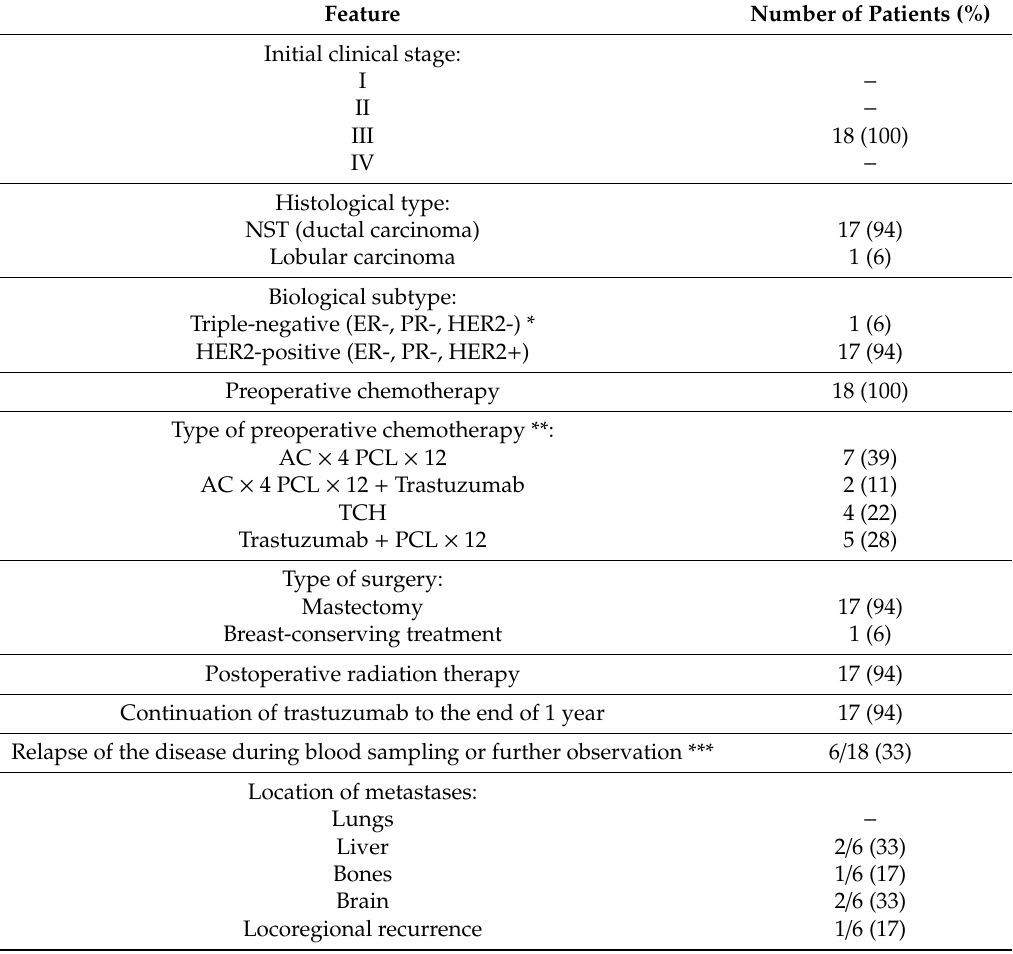
Table 1. Characteristics of patients with clinical stage III breast cancer ( n =